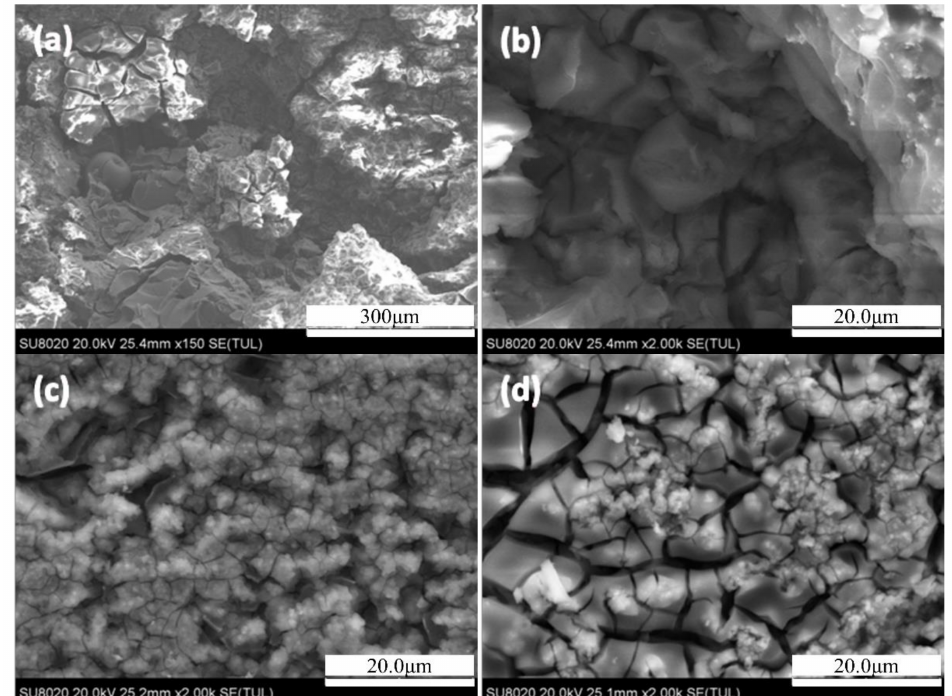
Figure 6. The internal morphology of the 7N01 extrusion aluminum alloy after non-isothermal aging at infiltrating 24 h: ( a ) SEM images under 150 magnification; ( b ) areas with severe corrosion under 2K magnification; ( c , d ) the part where corrosion is not obvious under 2K magnification.3.3.3. Corrosion surface